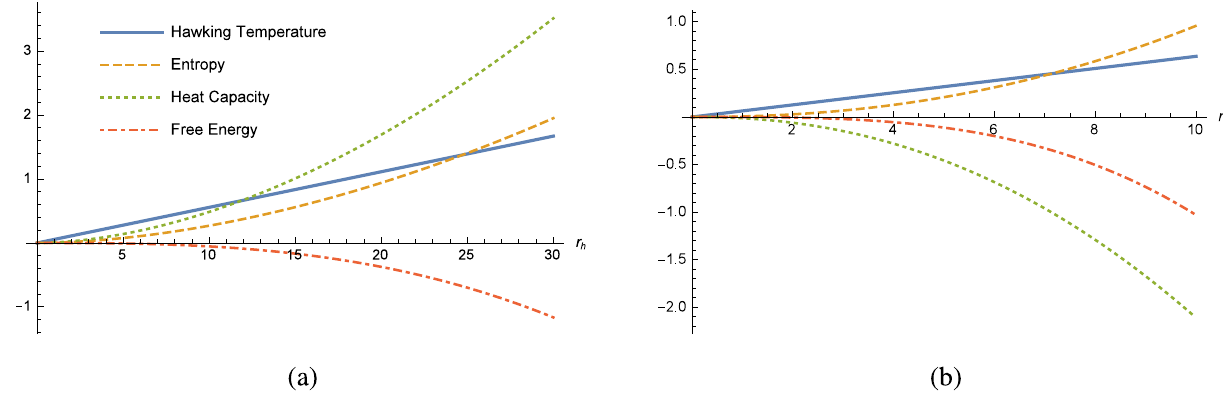
Fig. 4 Hawking temperature, entropy, heat capacity, and free energy for d U = 1 . 4 ( a ) and for d U = 1 . 6 ( b ) d C V =